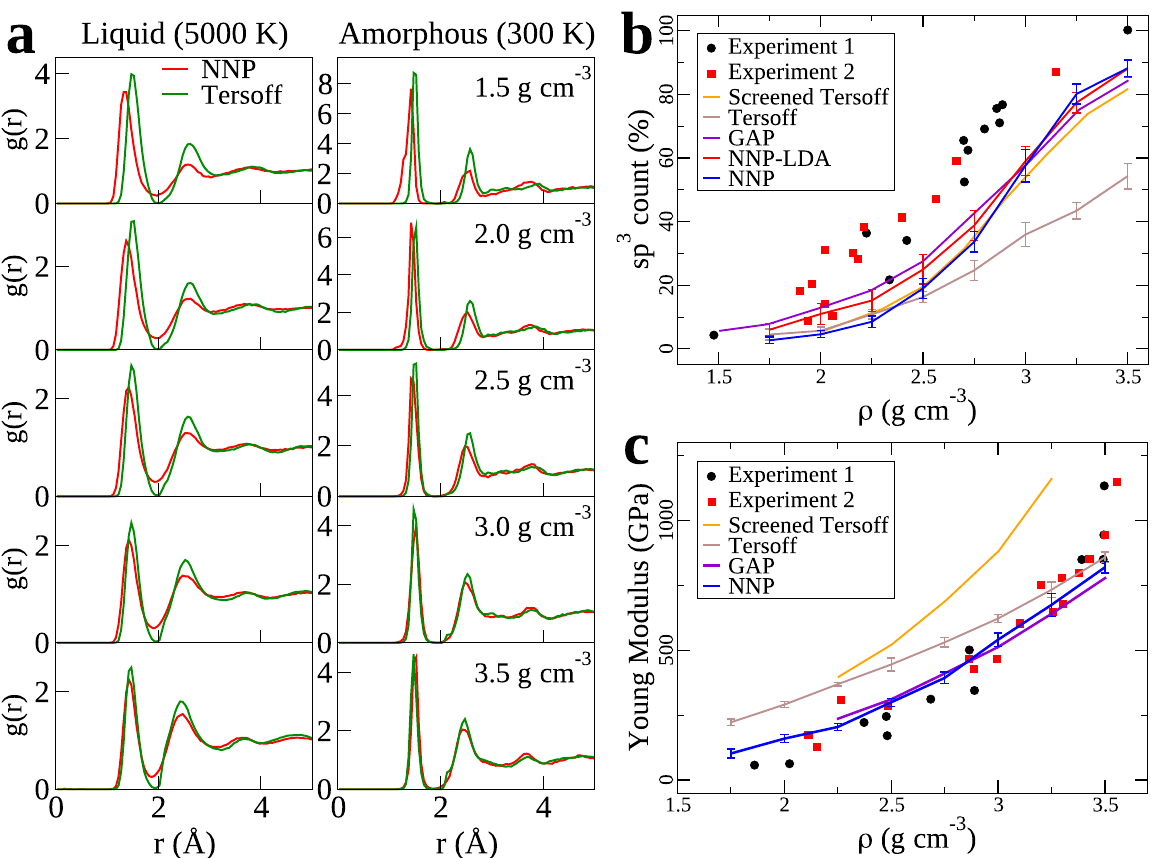
Fig. 6 Performance of the NNP on amorphous phases of carbon. a Radial distribution function for liquid (left) and amorphous (right) carbon, for our NNP and Tersoff potential, at increasing densities (top to bottom). b Percentage of tetrahedrally coordinated atoms in amorphous carbon structures as a function of density, comparing NNP with rVV10 and LDA-level, and Tersoff potential to results taken from ref. 21 for GAP and screened Tersoff potentials, as well as experimental results from refs. 42,43 . c Young modulus of amorphous carbon as a function of density for NNP at rVV10 level and Tersoff, compared to results taken from ref. 21 for GAP and screened Tersoff potentials, as well as experimental results from refs. 76,77 . Error bars represent standard deviation over ten random initialization of particle velocities of the melt-quench cycles at each